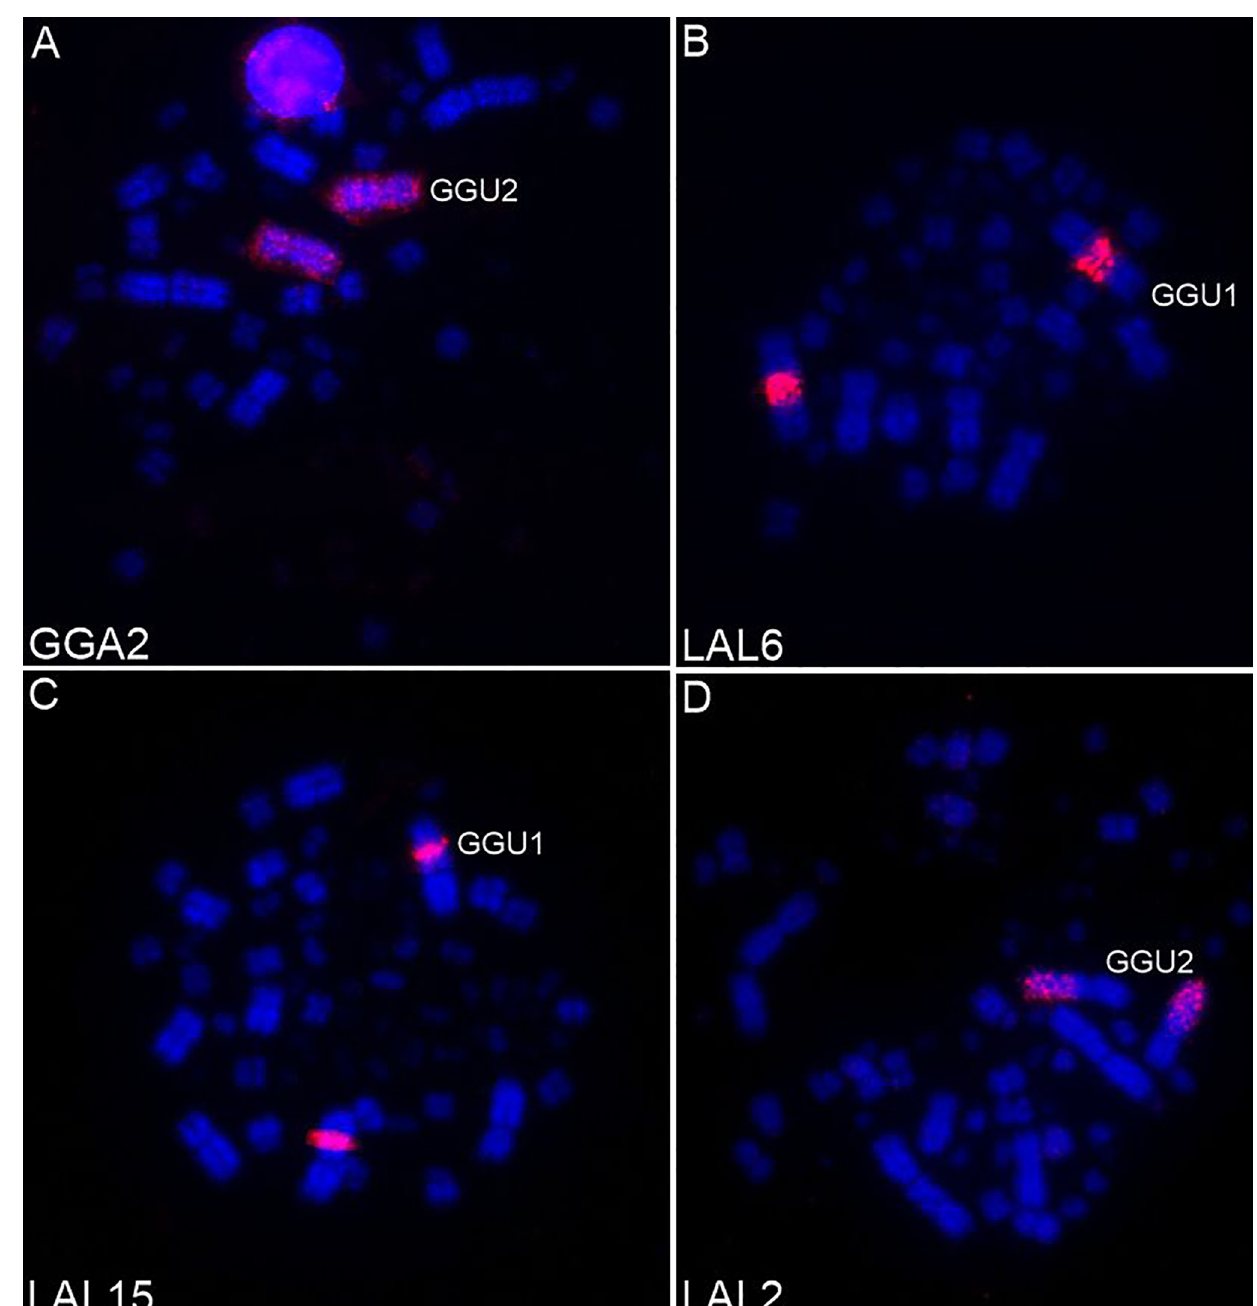
Fig 3. Examples of fluorescence in situ hybridization experiments with whole-chromosome probe derived from G . gallus (GGA) and L . albicollis (LAL) onto G . guira (GGU)